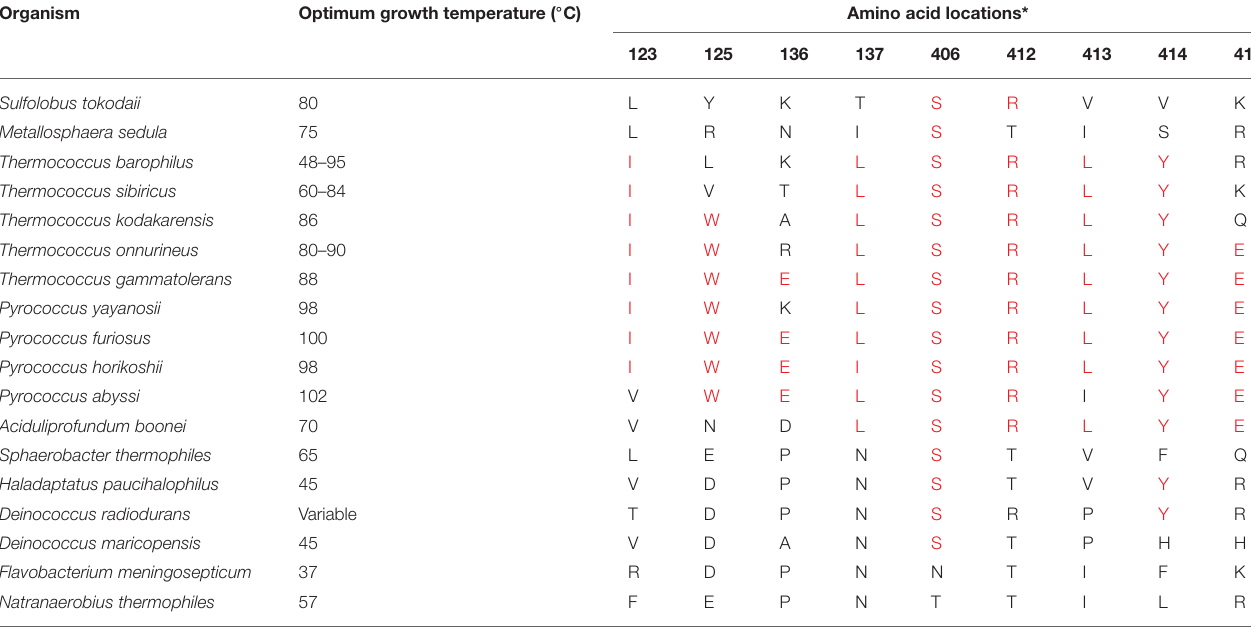
TABLE 2 | List of amino acid residues selected for introducing sequence guided substitutions in Flavobacterium meningosepticum prolyl endopeptidase gene sequence. Organism